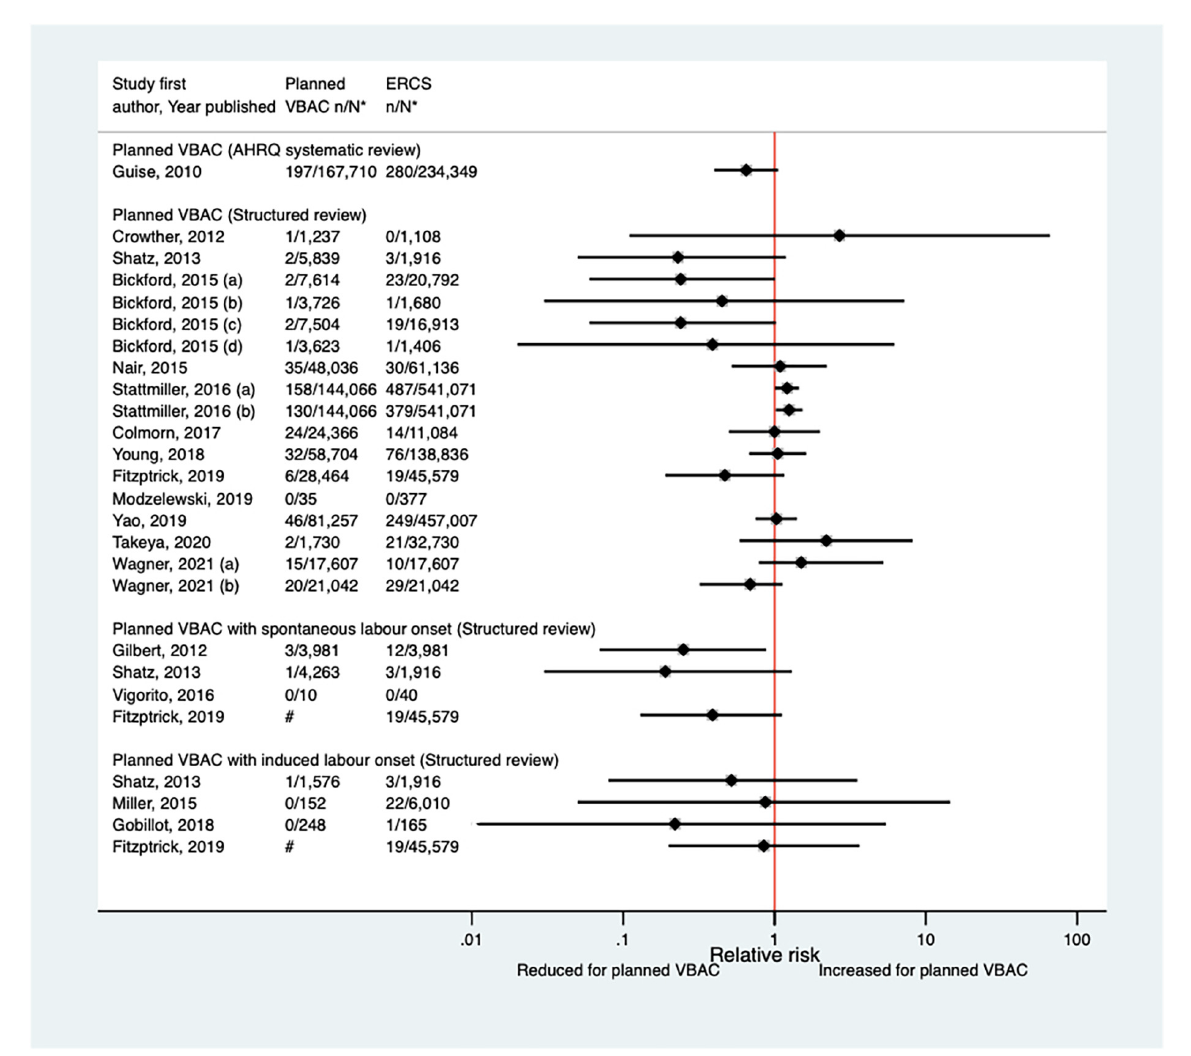
FIGURE2 Risk of hysterectomy for planned VBAC vs. ERCS. ∗ n , number in group with the outcome; N , Total number in group. Bickford and Janssen (50) (a) risk in women with 1–2 prior CSs only, (b) risk in women with 1–2 prior CSs and ≥ 1 prior VB, (c) risk in women with 1 prior CS only, (d) risk in women with 1 prior CS and ≥ 1 prior VB; Stattmiller et al. (55) (a) outcome: hysterectomy, (b) outcome: severe postpartum hemorrhage requiring hysterectomy. Wagner et al. (77) (a) Risk in women with no prior vaginal births. (b) Risk in women with ≥ 1 prior vaginal birth. # Numbers have not been shown to protect against potential disclosure risks. AHRQ, Agency for Healthcare Research and quality; CS, cesarean section; ERCS, elective repeat cesarean section; VBAC, vaginal birth after previous cesarean; VB, vaginal